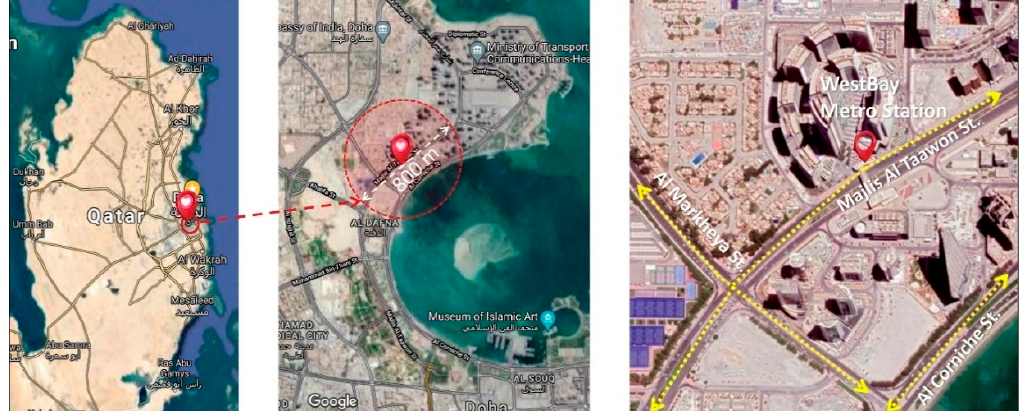
Figure 7. The location of West Bay metro station, shown within Qatar maps at different scales (Source: Google Earth, edited by the Authors).